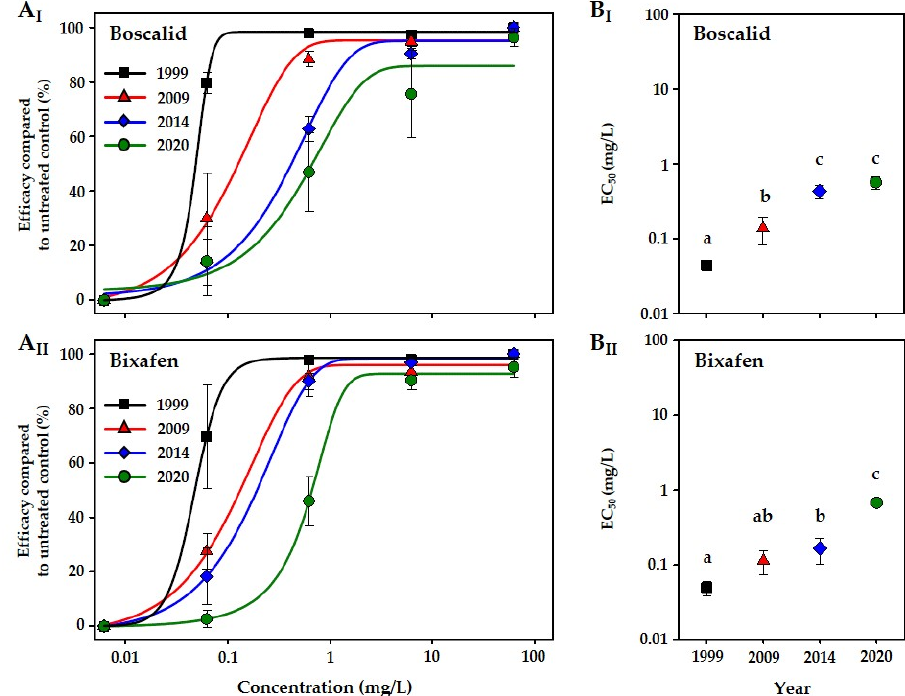
Figure 3. Changes in fungicide sensitivity of Zymoseptoria tritici field populations isolated in Northern Germany from two locations between 1999 and 2020 (isolation years 1999, 2009, 2014, 2020) to the succinate dehydrogenase inhibitors (SDHIs) boscalid ( A I , B I ) and bixafen ( A II , B II ) using microtiter assays. ( A I , A II ) Relationship between fungicide concentration and fungicide efficacy. Efficacy data (mean ± SD) of the several fungicide concentrations are expressed as a percentage reduction of fungal growth compared to the untreated control. Means ( ± SD) were calculated for each year of Z. tritici isolation and each concentration including both locations and three replications per location. ( B I , B II ) Comparison of EC 50 values (mg/L). EC 50 values (mean ± SD) were determined as the fungicide concentration reducing fungal growth by 50%. Means ( ± SD) were calculated from EC 50 values of both locations and three replications per location. Different letters describe significant differences in EC 50 values between years. Statistical significance was evaluated at p ≤ 0.05.